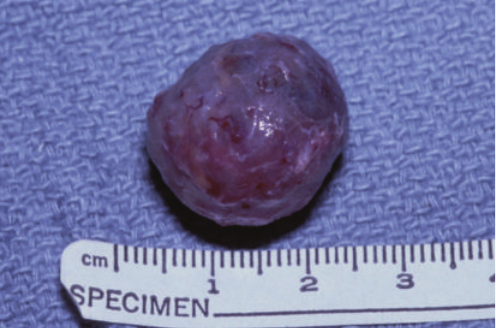
Figure 4: Gross operative specimen.